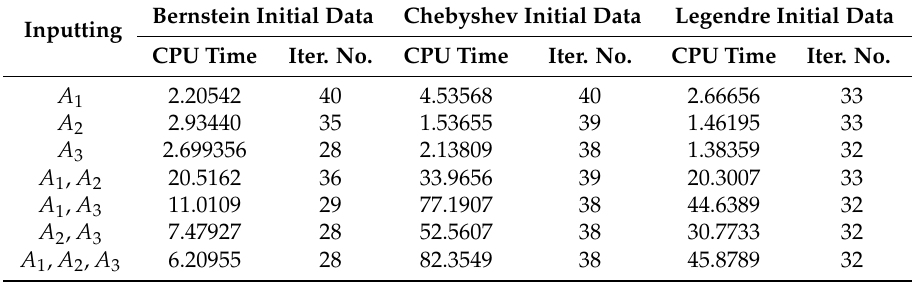
Table 2. Comparison of the number of iterations in Example 2.